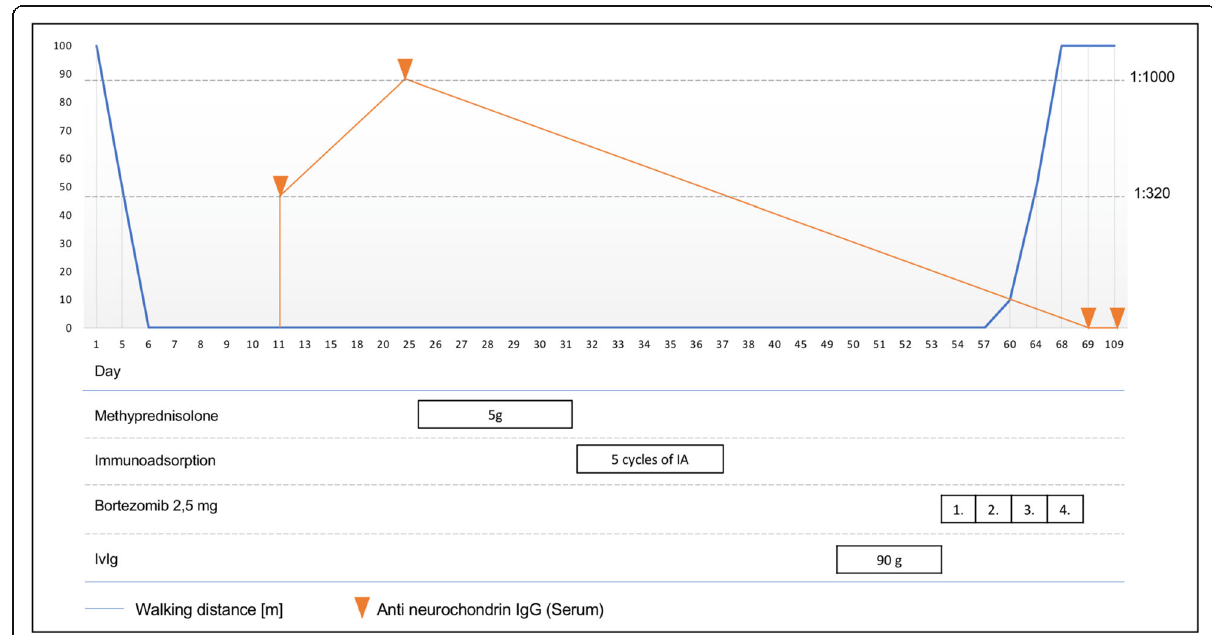
Fig. 2 Walking distance and anti-neurochondrin-Abs titers in relation to the course of therapy. Please note that the timeline on the x-axis is